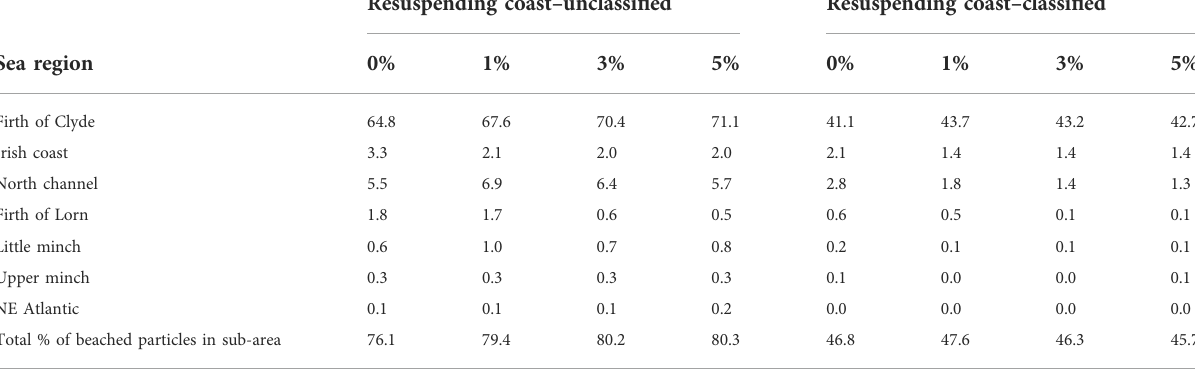
TABLE2Thepercentageofplasticlitteritems,ofthetotalreleasedparticles,that ‘ beached ’ attheendofeachmodelrun(day365)inthede fi nedsea- regions within the model sub-area. Sea-regions are presented following the fl ow of the Scottish Coastal Current (SCC), starting from the Firth of Clyde, and going northwards. Details of the SCC are provided in Supplementary Figure S1. Values have been calculated for 0%, 1%, 3% and 5% wind drift for the resuspending unclassi fi ed and the resuspending classi fi ed coastline to compare wind effect on beached particle